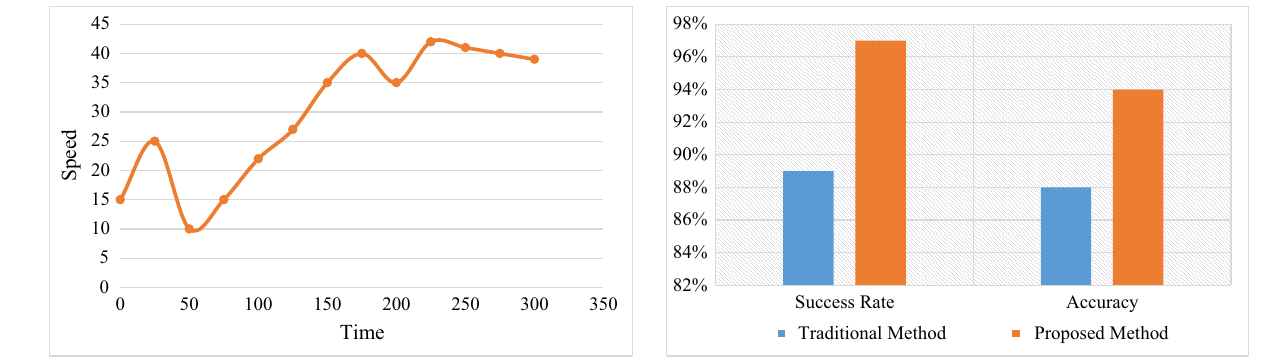
Figure 4: Motion correlation of root in motion reconstruction results.